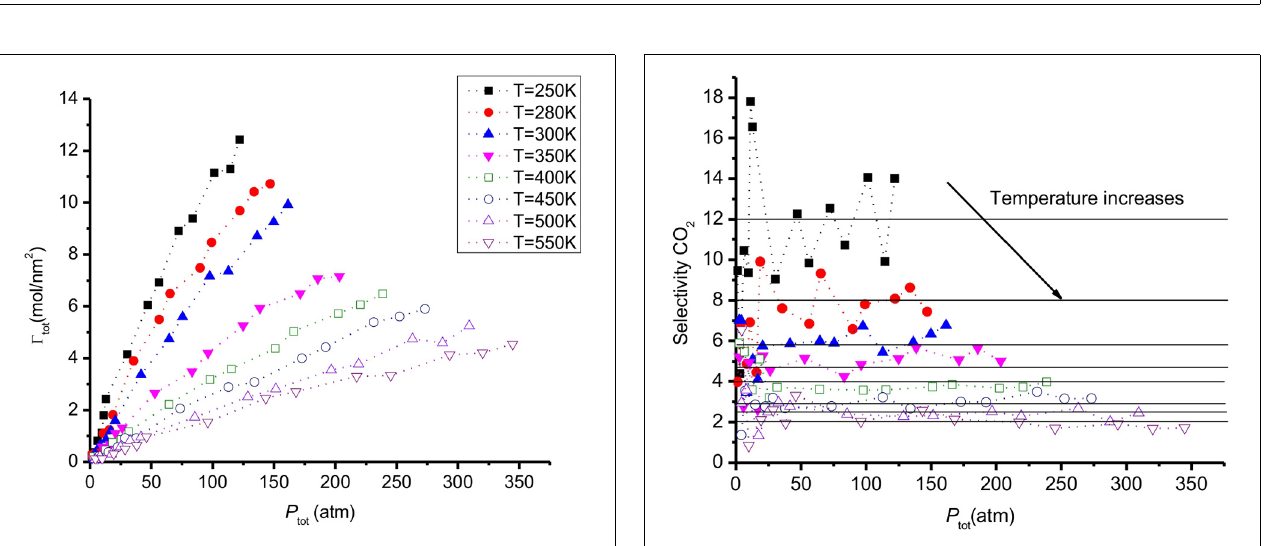
FIGURE 7 | Total amount of CO 2 /H 2 adsorbed on a graphite surface as a function of gas pressure at different temperatures.